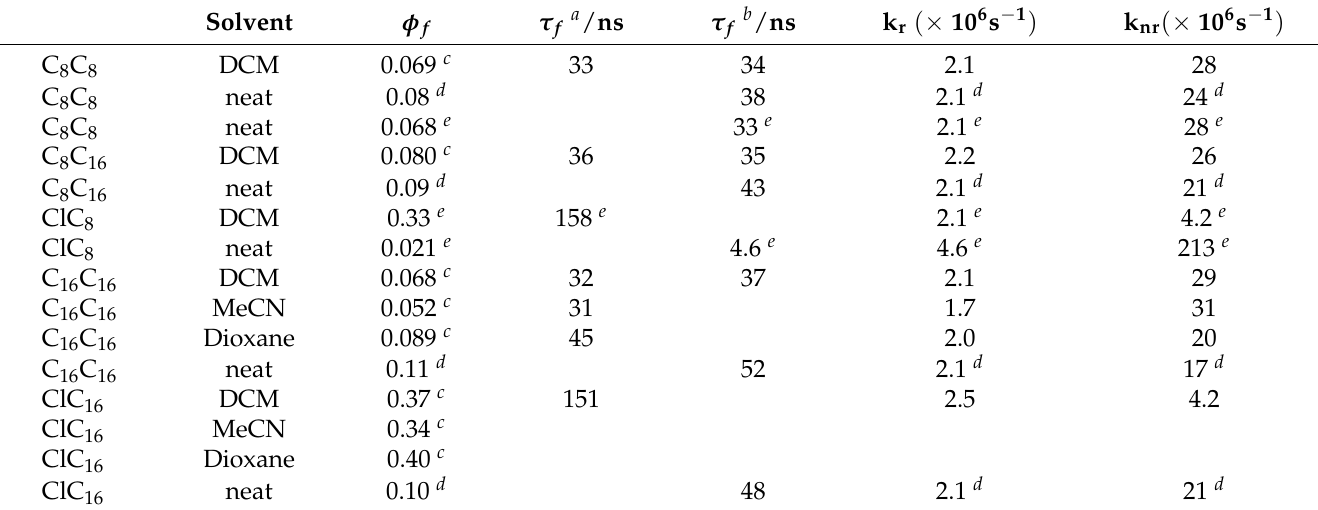
Table 2. Fluorescence parameters of the studied compounds: quantum yield φ f , fluorescence decay time τ f , radiative decay rate constant k r , and non-radiative decay rate constant k nr